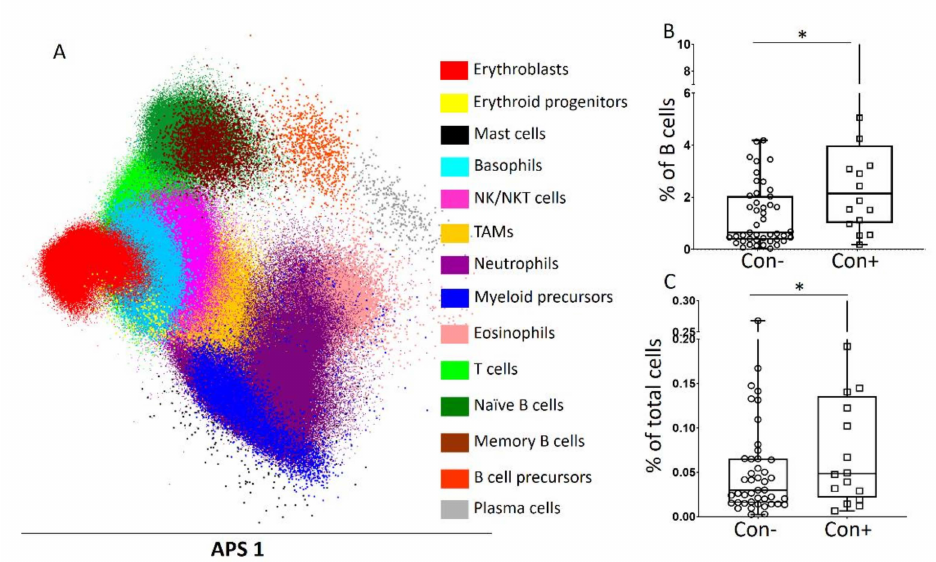
Figure 5. Bone marrow (BM) reconstitution post ASCT. ( A ) Individualized BM profile of a patient showing the relevant distribution of the various BM subsets. The density of each subset represents its relative abundance among total BM nucleated cells. ( B , C ) Memory B cell distribution between uncontaminated (con − ) and contaminated (con+) graft-derived BM as expressed among total B cells ( B ) and total nucleated cells ( C ). * p < 0.01; TAMs, tumor-associated